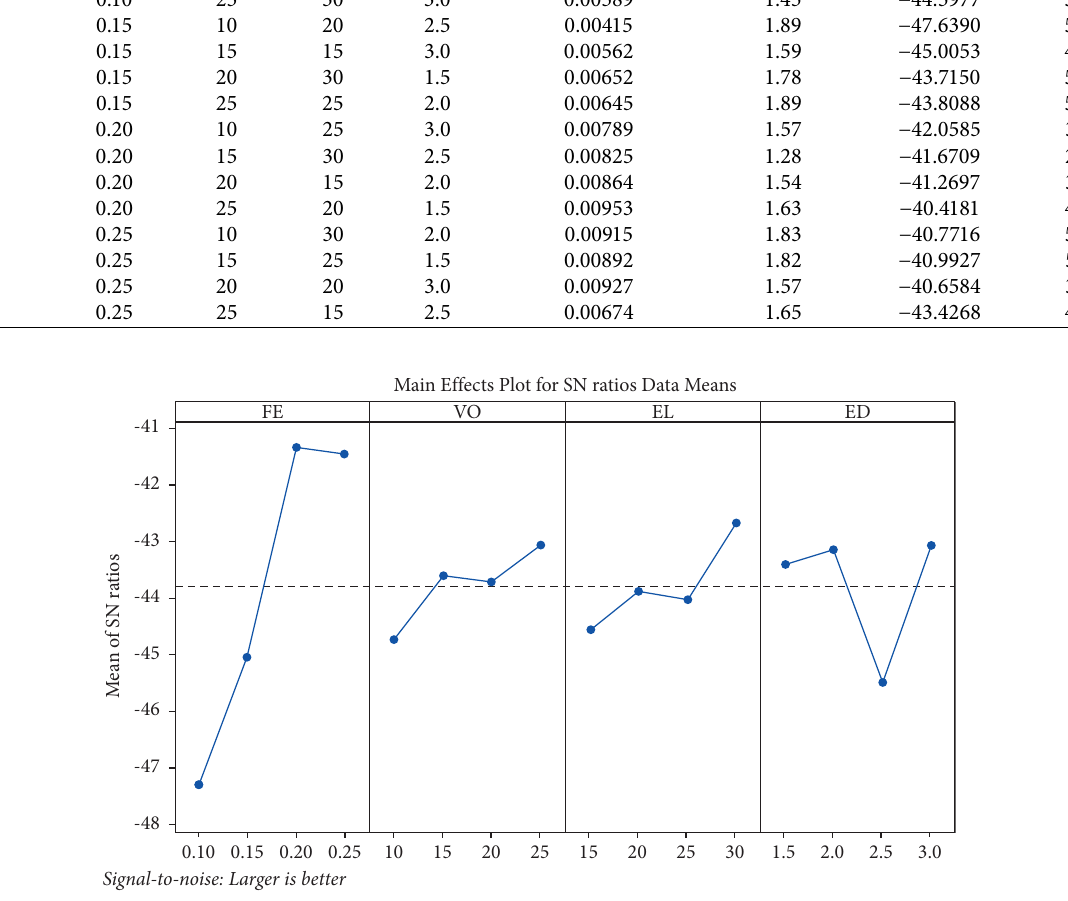
Figure 4: SN ratio plot on MRR. Table 6: SN response for MRR (larger is better).